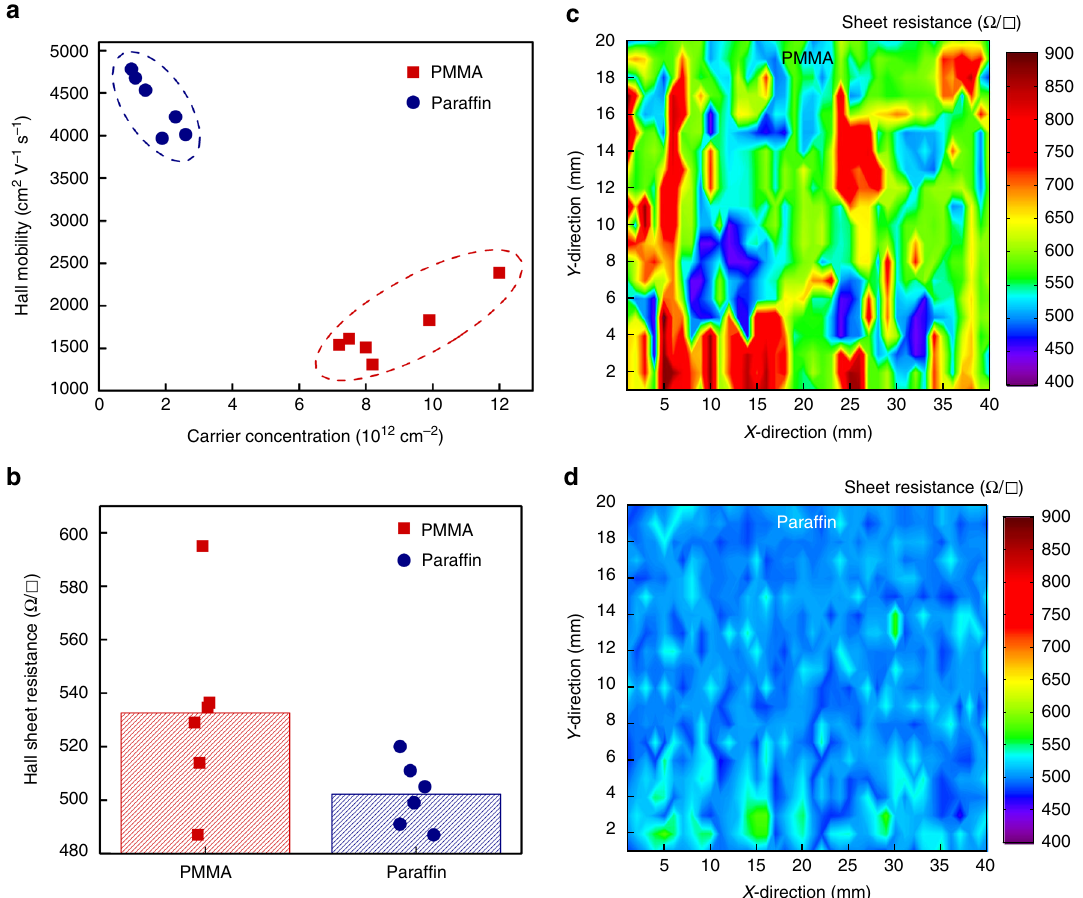
Fig. 2 Electrical properties comparison of graphene transferred with PMMA and paraf fi n support layers. a Room-temperature hall mobility versus carrier concentration of graphene fi lms transferred with different support layers as indicated. Each data were extracted from a 15 × 15 mm 2 graphene transferred on Si/SiO 2 substrate using Hall measurement in the presence of 2800 Gauss magnetic fi eld. b Sheet resistance distribution of graphene fi lms transferred with different support layers, obtained via Hall measurement. c , d Spatial sheet resistance maps of a graphene fi lm transferred with c PMMA and d paraf fi n support layers. Eight hundred sheet resistance values were measured using four-point probe measurement over a graphene area of 40 × 20 mm 2 , with 1 mm step size in both x - and y -directions. The paraf fi n-transferred graphene fi lm exhibits much lower and homogenous sheet resistance than that of PMMA. In fi gure a , b , blue-color round-shaped symbols represent paraf fi n-transferred graphene, and red-color square-shaped symbols represent